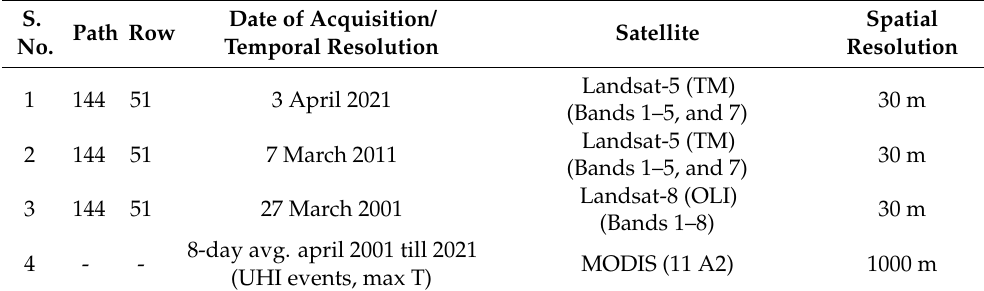
Table 1. Details of the datasets used in this study.